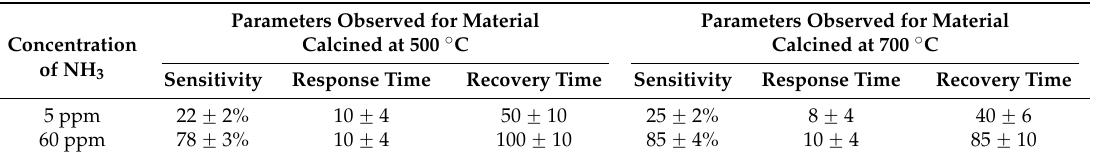
Table 1. Relative performance of In 2 O 3 for sensing ammonia at two different calcination temperatures between 500 and 700 ˝